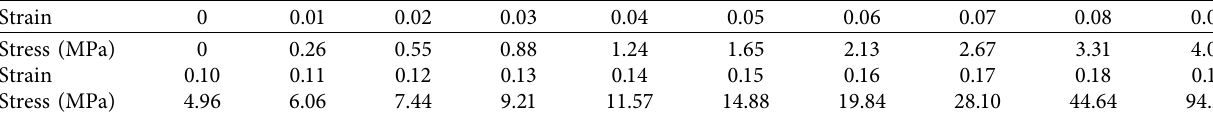
Table 3: The double-yield model cap